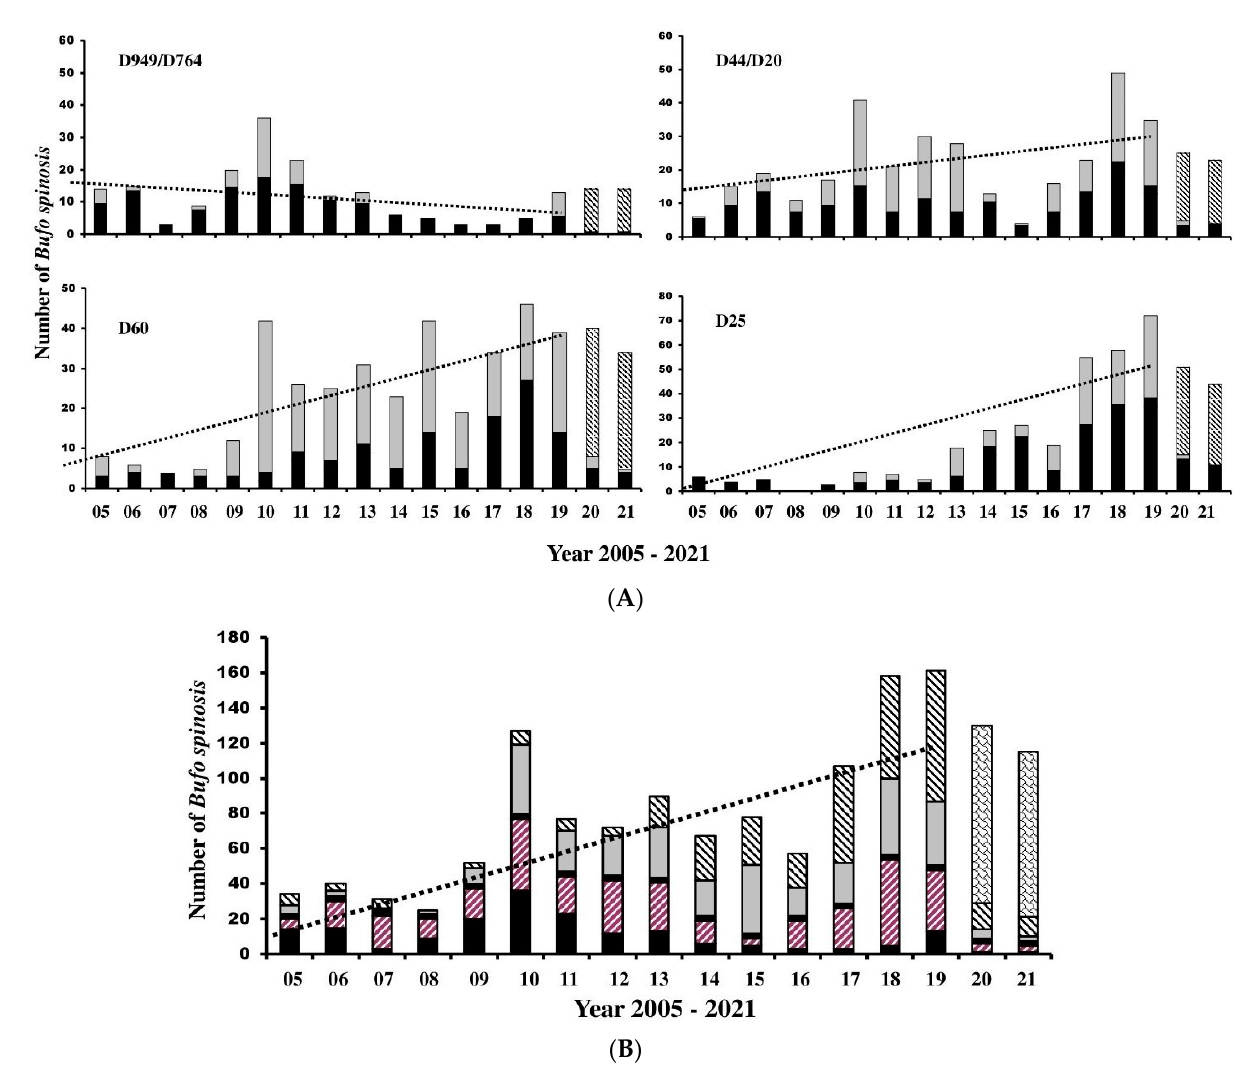
Figure 6. ( A ) Histograms showing mortality counts from 2005 to 2021 for all four areas. Solid bars represent large females ( ≥ 80 mm SVL), gray bars smaller individuals (either sex) and scaled bars represent estimates derived from the Poisson distribution for 2021 and 2022. Note differences of scale between the y-axes. ( B ) Pooled histograms from all four regions. Black bars represent D949/D764, backward cross-hatched bars D44/D127, gray bars D60 and forward-hatched bars D25. Dotted lines were calculated from the regression equations for each population given in Table 2. See text for further details.